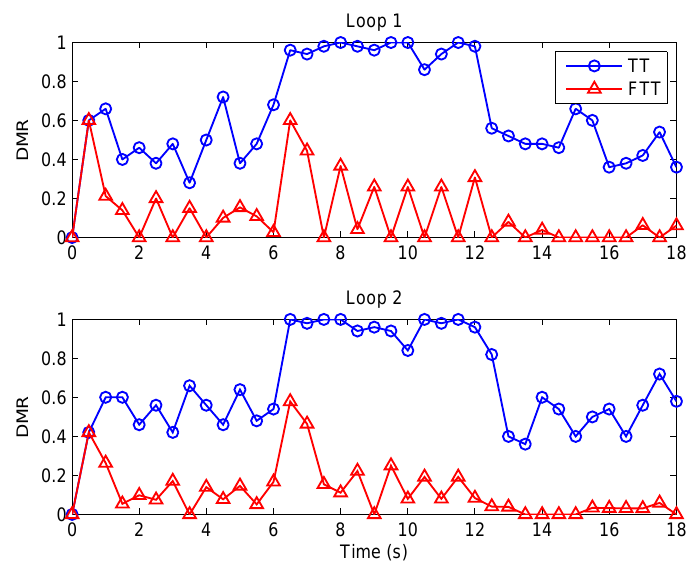
Figure 9. Deadline miss ratio under slight interference.